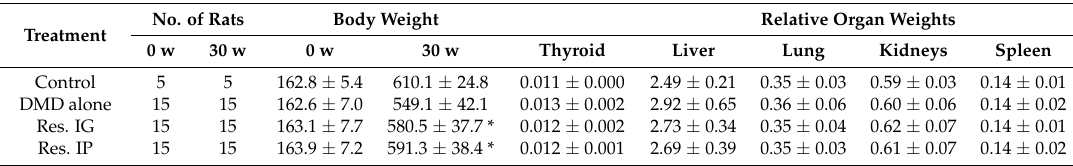
Table 1. The average weights (g) of animal body and major organs.